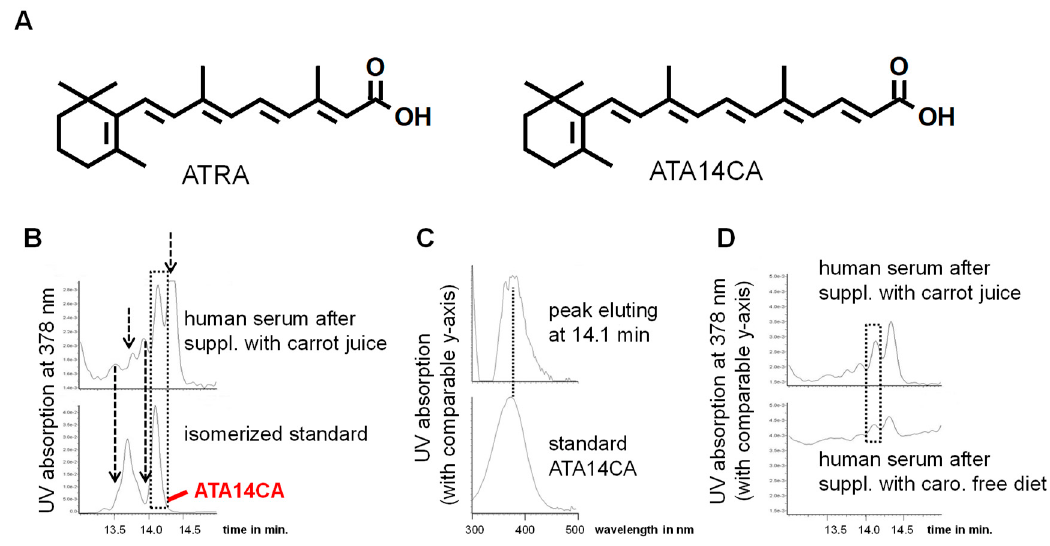
Figure 1. Apo-14´-carotenoicacid(A14CA)isanendogenousoccurringapo-carotenoid. ( A )Representative structural formula of all- trans retinoic acid (ATRA) and all- trans -A14CA (ATA14CA). ( B ) Representative chromatograms showing a co-elution of the all- trans -isomer of a photo-isomerized standard solution from ATA14CA with a peak present in human serum after supplementation with carrot juice obtaining comparable retention time of 14.1 min marked by a dashed lined box, additional unknown peaks were marked with dashed line arrows. The peaks eluting before ATA14CA obtain similar UV spectra like ATA14CA and are likely geometric isomers of ATA14CA, while the unknown peak eluting after ATA14CA obtains an UVmax of 434 nM and is likely a hydrogenation metabolite of ATA14CA. ( C ) UV spectra of the peaks eluting at 14.1 min. originating from human serum after supplementation with carrot juice and ATA14CA standard compound obtaining an UVmax of 378 nm. ( D ) Representative chromatograms from human serum after supplementation of a carotenoid free diet and after supplementation with carrot juice focusing on ATA14CA eluting at 14.1 min and marked by a dashed line